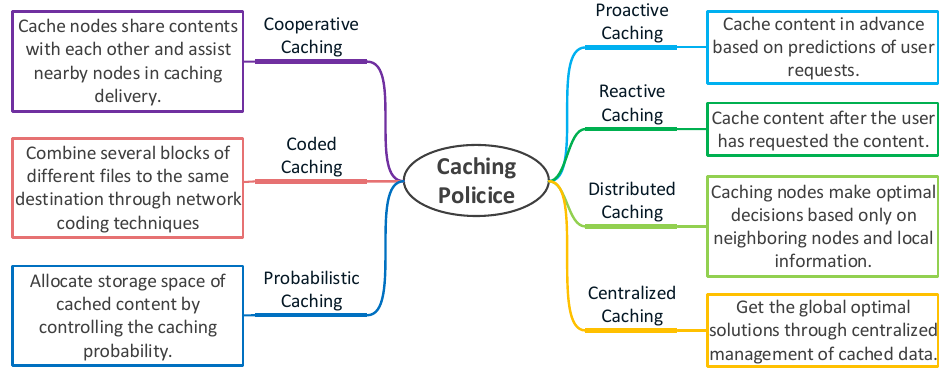
Figure 4. Caching